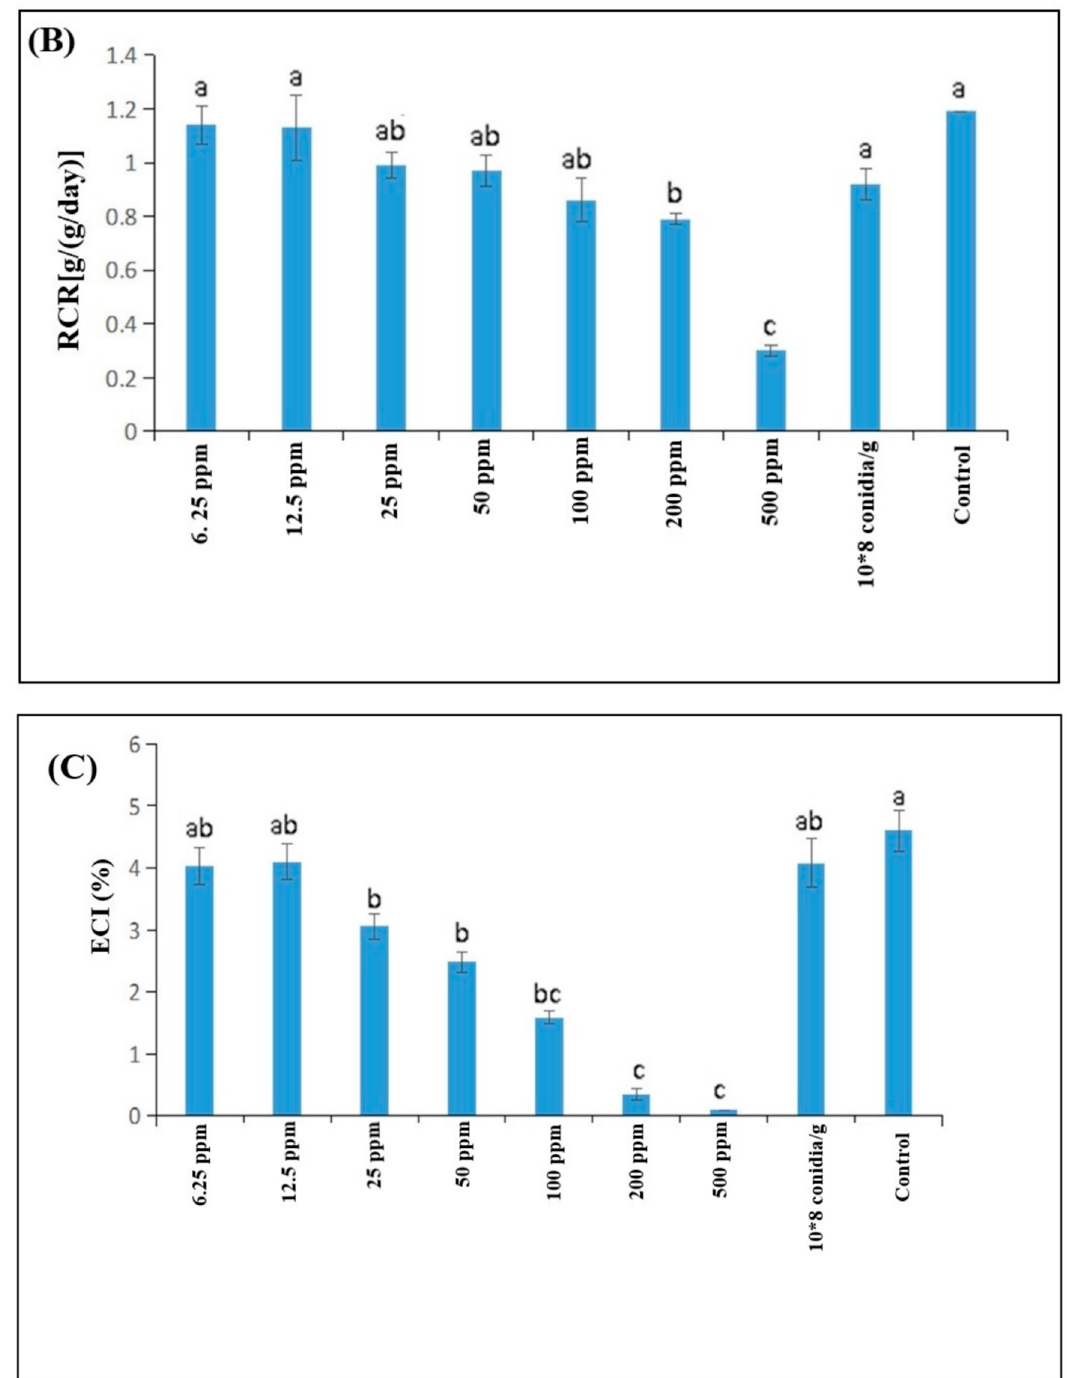
Figure 6. Feeding and growth parameters of 2nd instar Spodoptera litura larvae in response to di ff erent treatments of Beauveria brongniartii Fe 0 NPs, B. brongniartii conidia alone and control. ( A ) relative growth rate; ( B ) relative consumption rates and ( C ) percentage food conservation e ffi ciency. Error bars indicate standard error of means. Di ff erent letters above columns indicate significant di ff erences between means at a 5% level of significance.